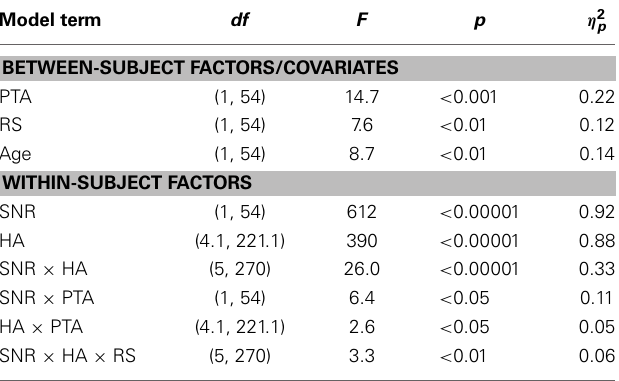
Table 4 | Results from the ANOVA performed on the speech scores.